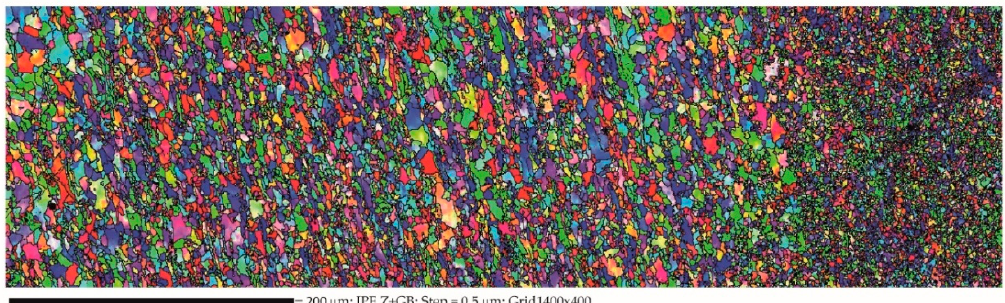
Figure 7. Detail of grain coarsening in the high-temperature heat-affected zone (HAZ) as it is shown in Figure 6.